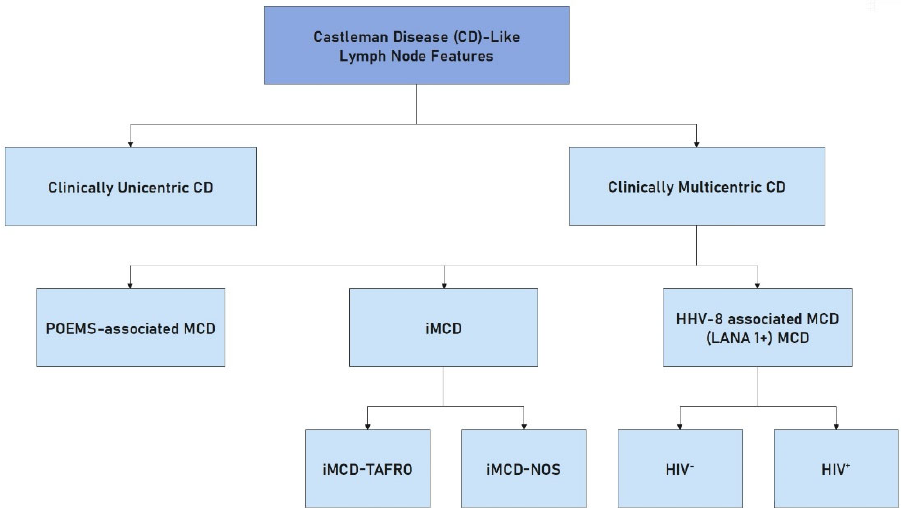
Figure 1. Classification of Castleman disease.